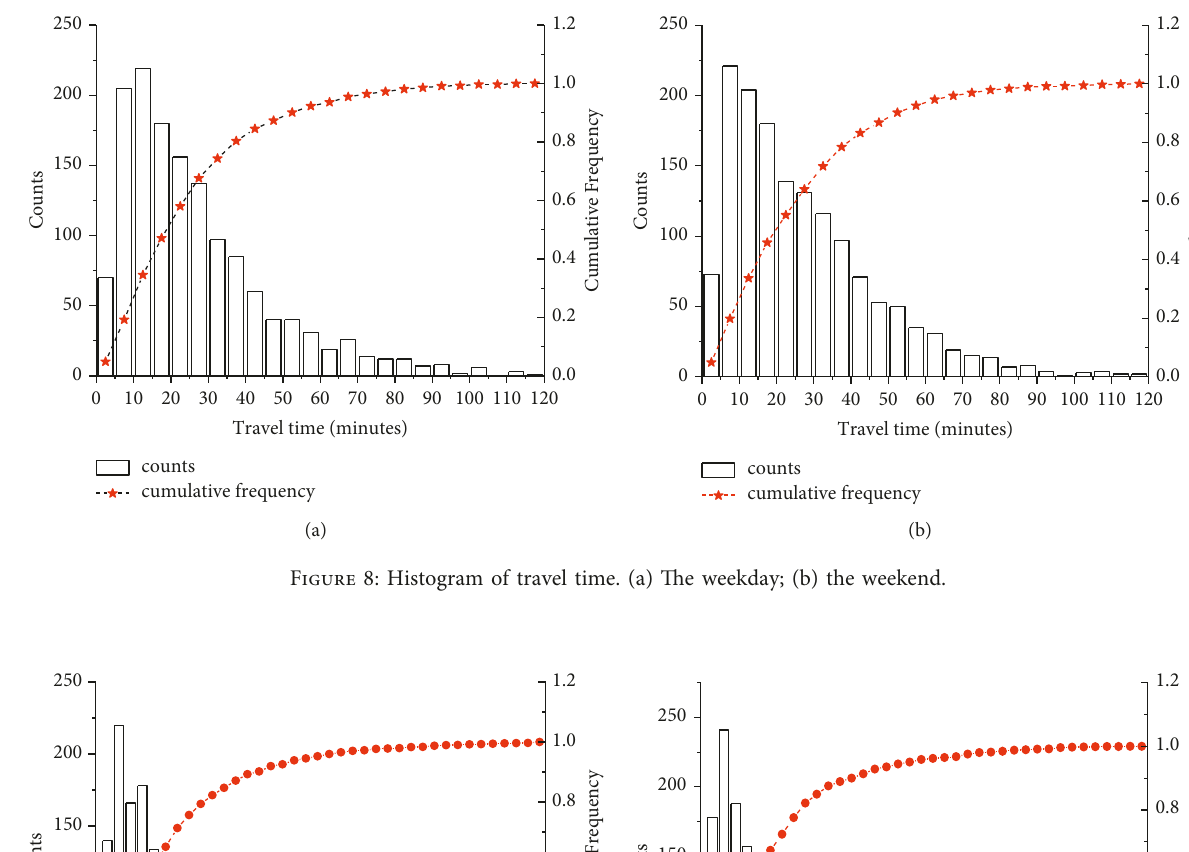
Figure 8: Histogram of travel time. (a) The weekday; (b) the